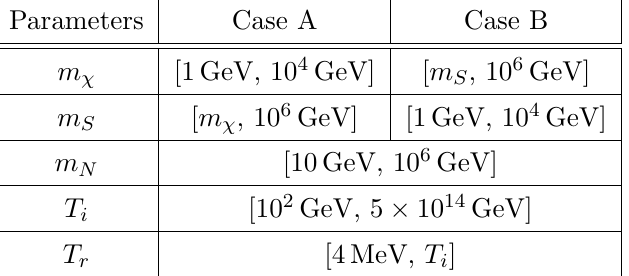
is fully determined (cid:23)